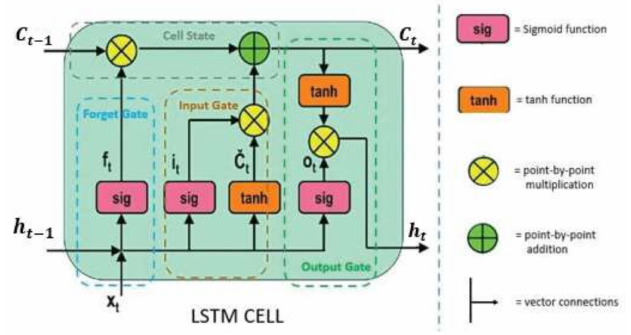
Figure 5. LSTM unit with its gates and cell